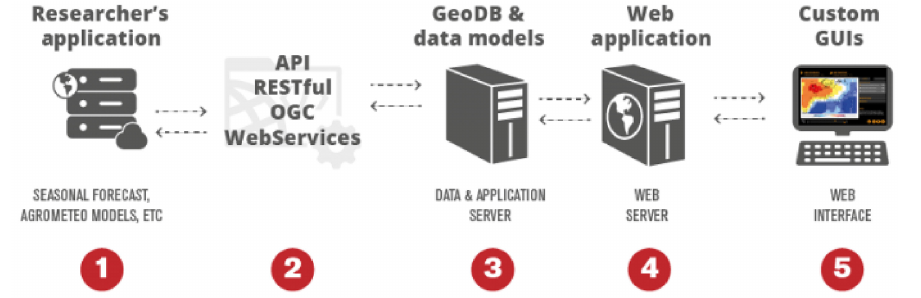
Figure 1. IBIMET-CNR infrastructure components of climate service